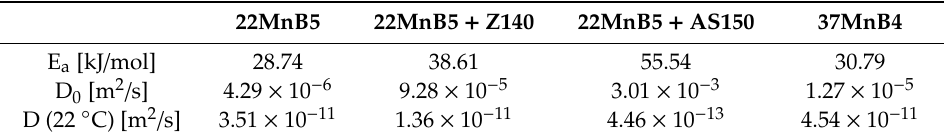
Table 5. Determined activation energies and pre-exponential diffusion coefficients from the desorption curves as well as the calculated diffusion coefficients at room temperature.